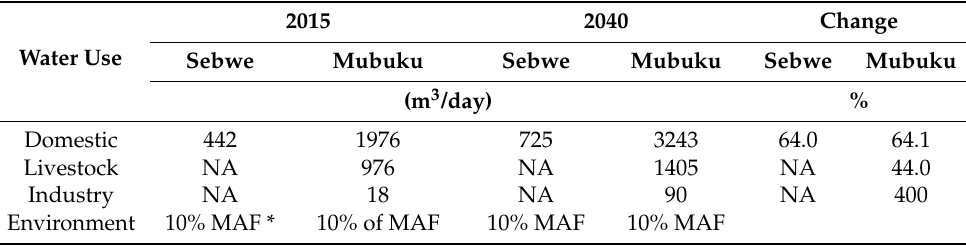
Table 6. Domestic, Livestock, Industry and Environmental water demand.